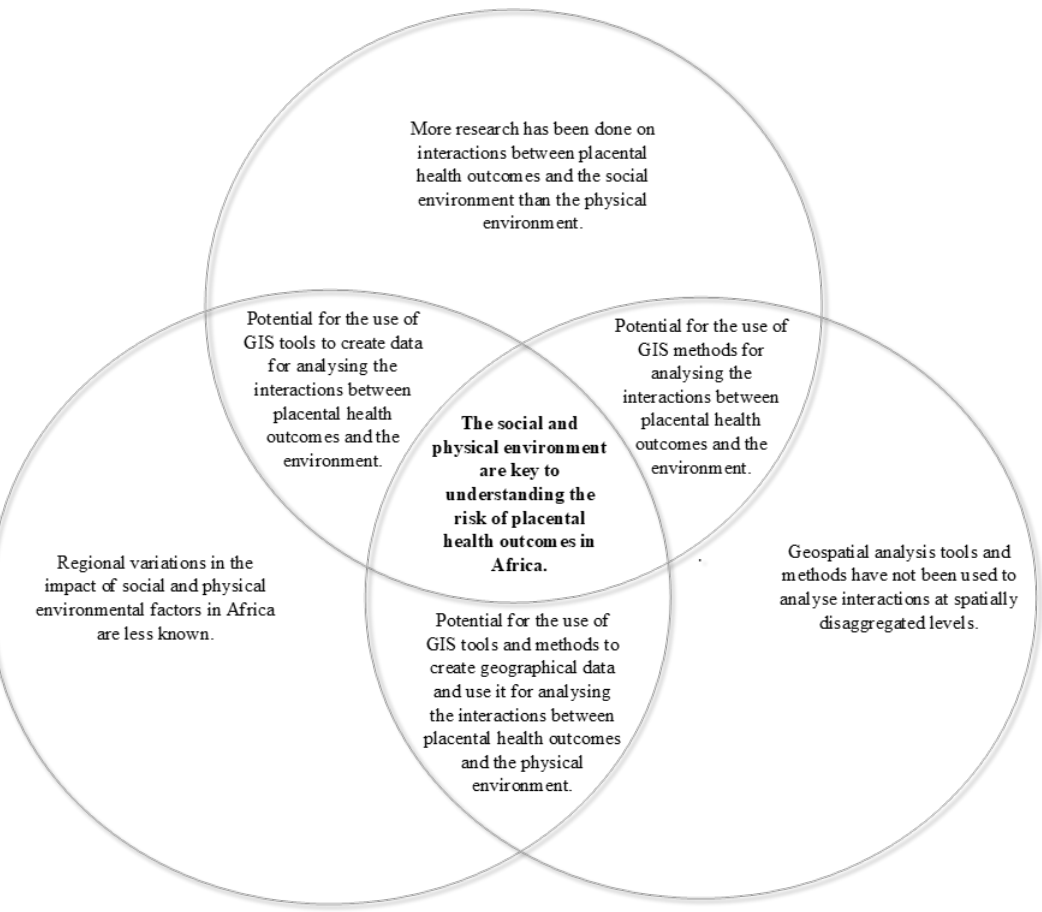
Figure 3. Key messages form the scoping review. GIS: Geographical Information Systems.